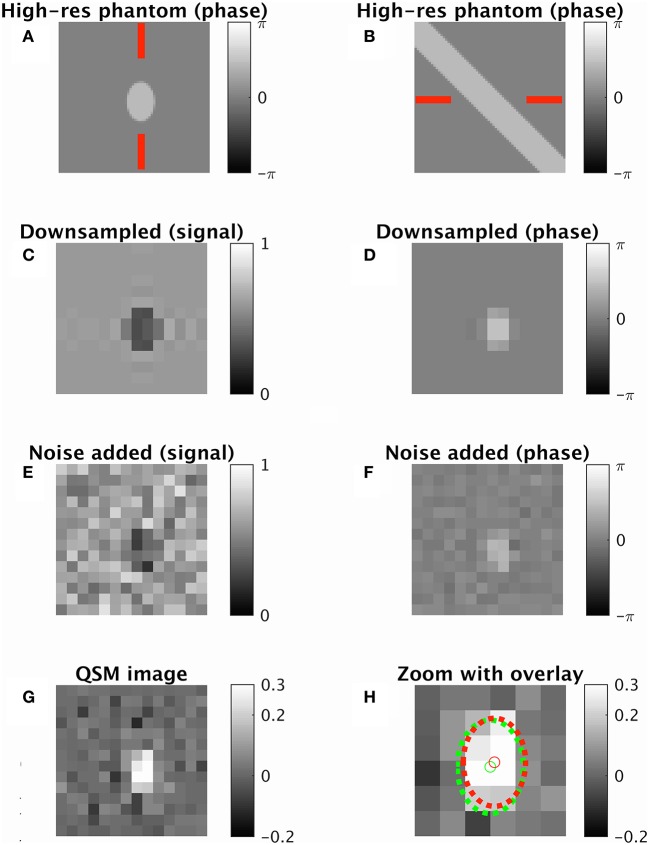
An example of the synthetic data generation using default parameters from Table 1. A single cross-sectional slice is shown of a vein oriented 45° away from the imaging plane (radius 1.3 voxel widths, cross-sectional area approximately 7.5 squared voxel widths). (A,B) High-resolution phase image two orthogonal views (shown by red lines). (C,D) Downsampled image with magnitude image (C) and phase image (D). (E,F) Downsampled complex image with noise added. (G) QSM map taken from processed image. (H) Zoomed QSM map overlaid with vein center and perimeter for ground truth (green) and ICF prediction (red). True χvein = 0.3 ppm. ICF estimate 0.35 ppm. MIV estimate 0.42 ppm. ICF radius estimate 1.17 voxels.